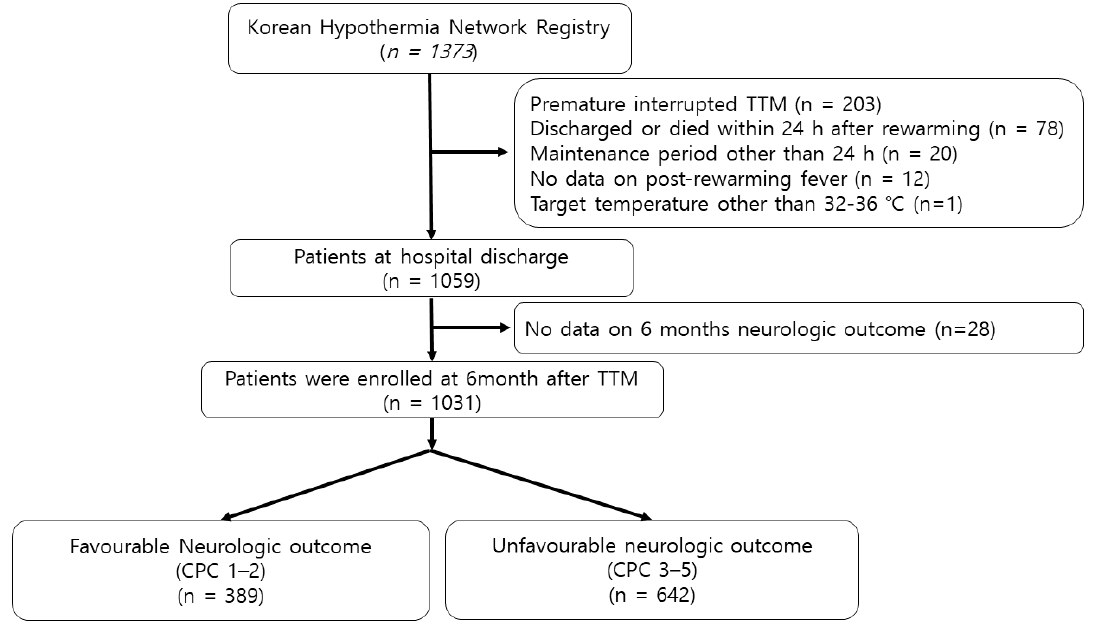
Figure 1. Flow diagram of the study. TTM, targeted temperature management; CPC, cerebral performance category scale.